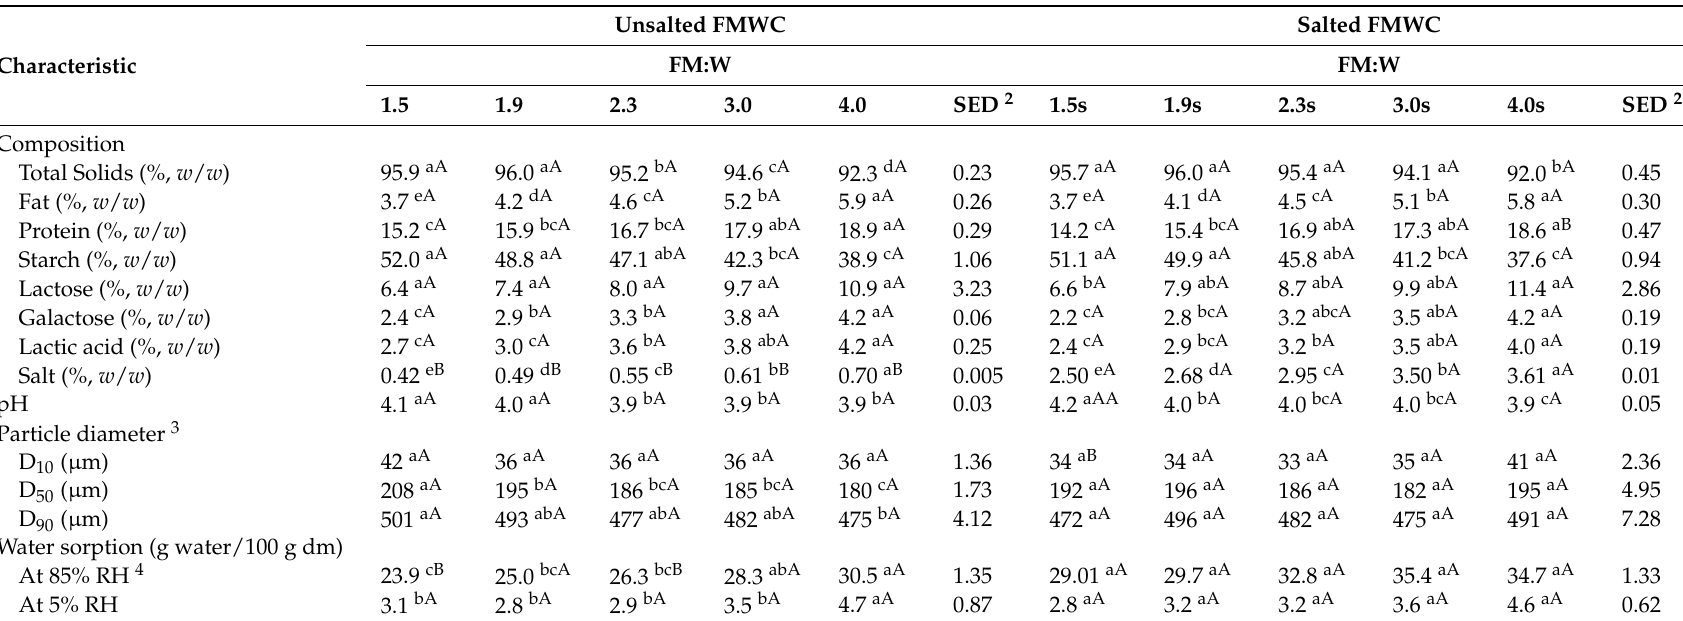
Table 2. Effect of ratio of fermented milk-to-parboiled wheat (FM:W) on the characteristics of fermented milk-wheat composites (FMWC) 1–4